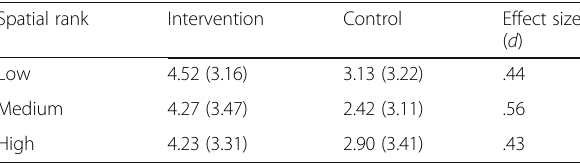
rank for each cohort Spatial